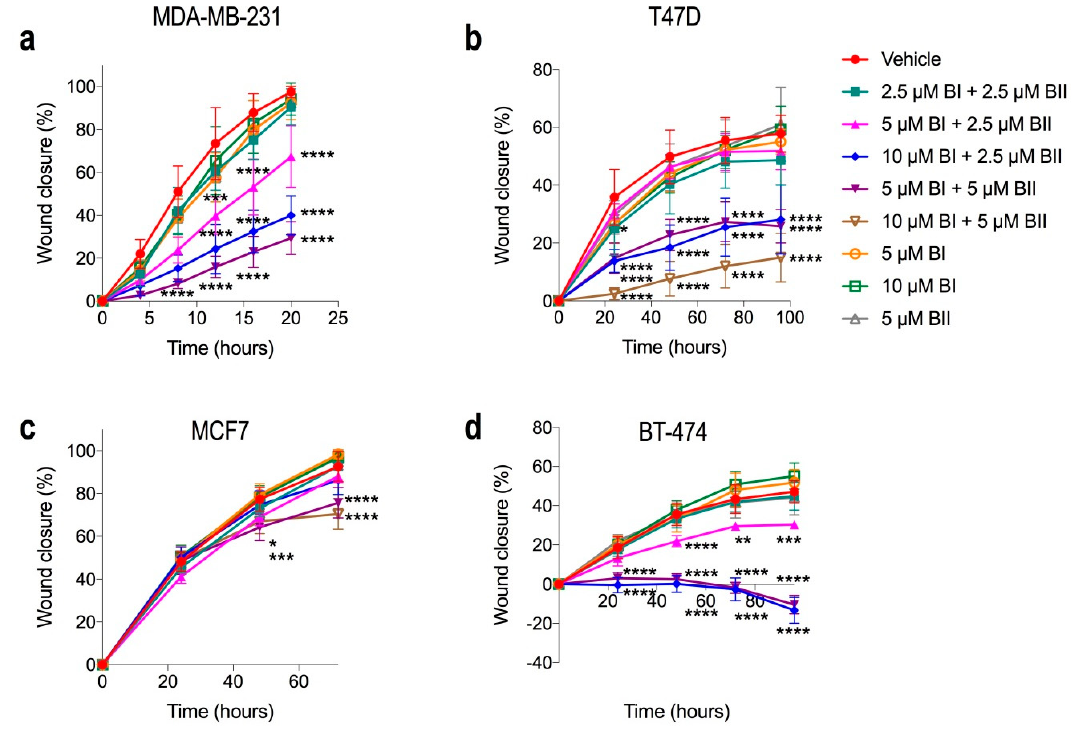
Figure 5. Cytotoxic and non-cytotoxic combinations of bac I and II reduced breast cancer cell migration. ( a – d ) The percentage of wound closure relative to closure at time 0, for MDA-MB-231 ( a ), T47D ( b ), MCF7 ( c ) and BT-474 ( d ). Wound area was measured using NIS-Elements software (Nikon, Tokyo, Japan). Data are the mean ± SD of six replicates from a representative experiment repeated in triplicate. P-values are for closure relative to vehicle at each time point, determined by one-way ANOVA with Bonferroni test (* p ≤ 0.045; ** p = 0.003; *** p ≤ 0.0007, **** p < 0.0001).